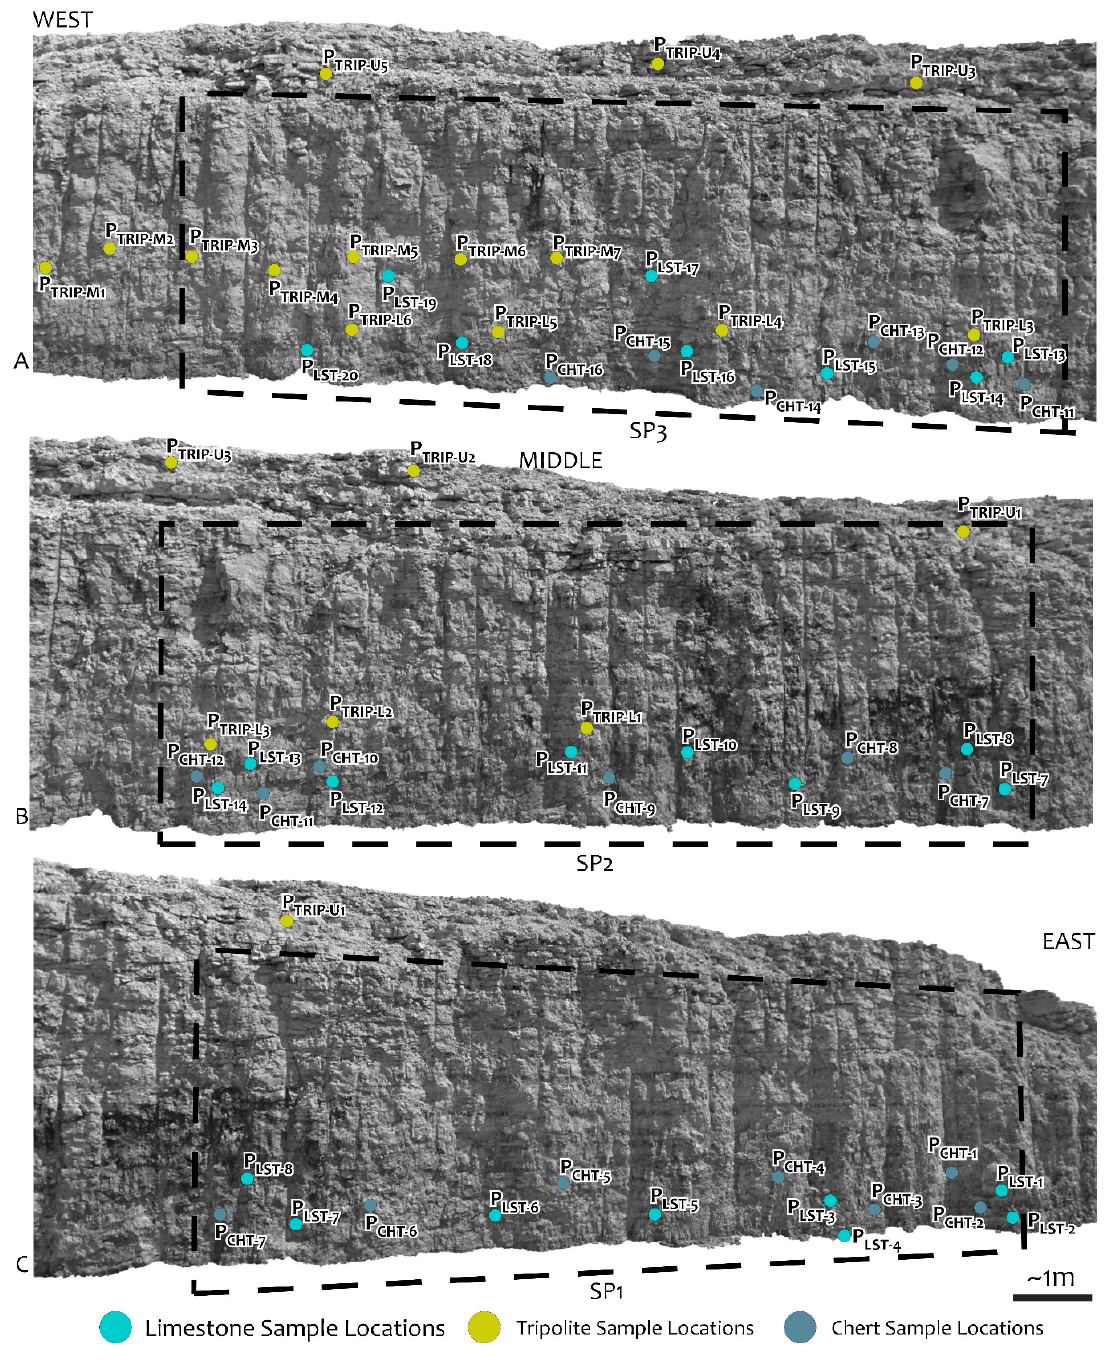
Figure 5. Field sampling locations on the investigated roadcut. Collected sample names were abbreviated as TRIP, LST, and CHT for tripolite, limestone, and chert, respectively. The subscripts in the tripolite sample names refer to samples collected from the upper (U), middle (M), and lower (L) levels of the roadcut. The dashed lines show the extent of the ground-based hyperspectral images from ( A ) Scan Position 3 (SP3) to the west, ( B ) SP2 in the middle, and ( C ) SP1 to the east of the roadcut. The digital images are courtesy of Google Earth Pro (Image data: Google, Image date: July 2014).